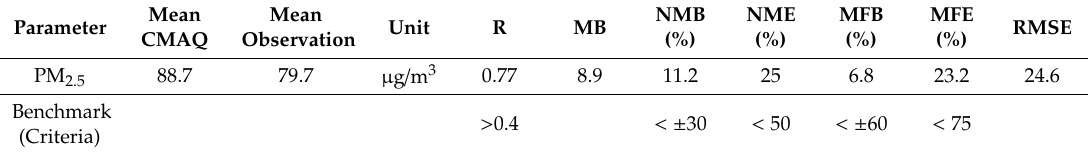
Figure 7. Comparison of simulated (black line) and observed (red line) PM 2.5 in December 2010. The grey bars denote nighttime periods. Table 3. Statistical parameters of CMAQ performance for daily concentrations of PM 2.5